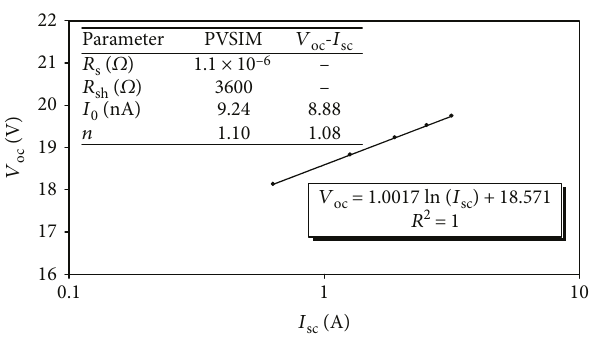
Figure 10: Relation between V simulated with PVSIM. The accompanying table lists the values of R , R , I , and n used in the simulations and compares I s sh 0 with that obtained from the V Table 4: Saturation current and ideality factor for a 14 Wp a-Si:H module obtained from V